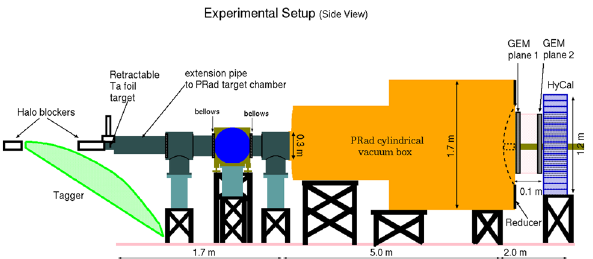
Fig. 48 Schematic of the experimental setup